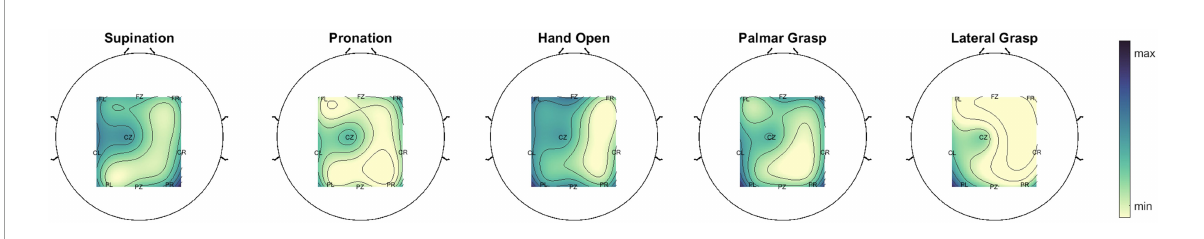
FIGURE9 Overall effect of the delta band on all frequency bands. The topoplots were averaged over all participants and trials for the five movement attempts. They represent the average CFC between the delta band and all other frequency